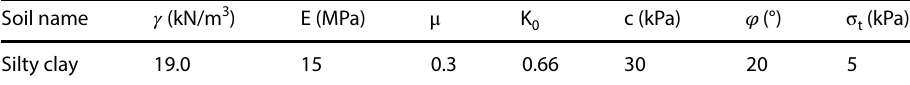
Table 1 Geotechnical parameters for simulations